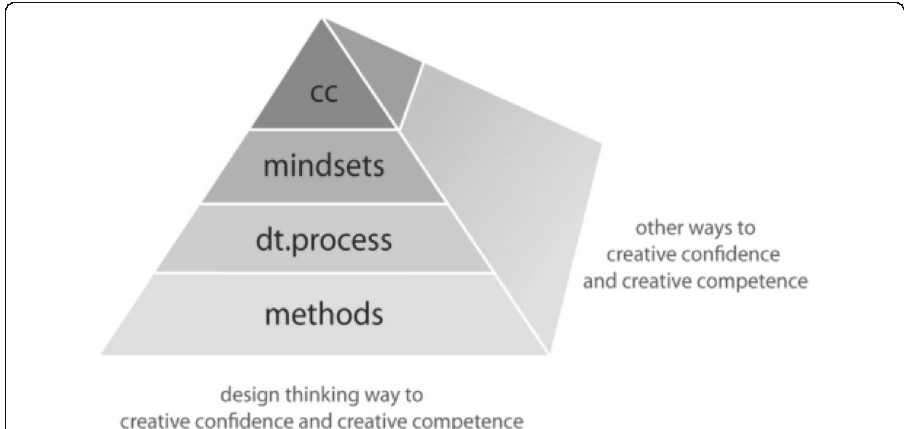
Fig. 3 Rauth et al. ’ s (2010, p. 7) development of creative confidence and competence through design thinking and other